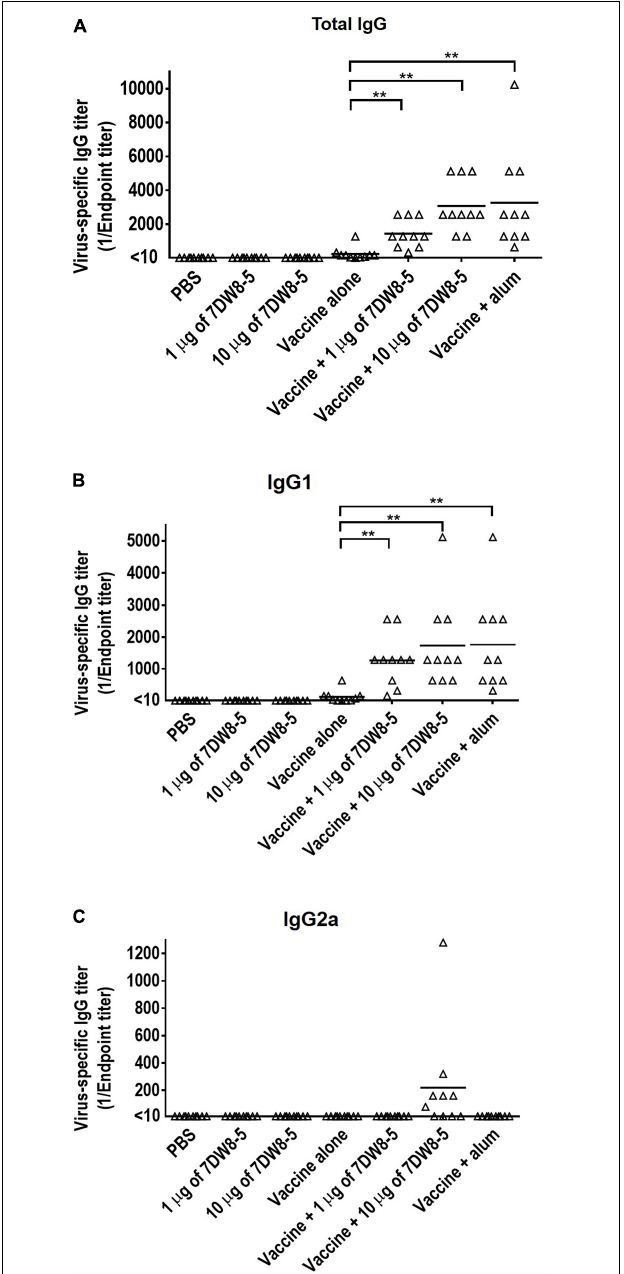
FIGURE 1 | Virus-specific antibody titers induced by 7DW8-5 in combination with HA vaccine in mice. Six-week-old BALB/c mice ( n = 10) were immunized with a commercial influenza HA vaccine with or without adjuvant twice with a 2-week interval between the vaccinations. Blood samples were collected 2 weeks after the second immunization. Virus-specific antibodies were measured by using an ELISA with inactivated and purified CA07 virus as the coating antigen. (A) Virus-specific total IgG antibody titers; (B) virus-specific IgG1 antibody titers; (C) virus-specific IgG2a antibody titers. The data were analyzed by using a one-way ANOVA followed by Tukey’s Post Hoc tests. The data were log2 transformed before the comparisons to stabilize the variance. The lines indicate the means of the antibody titers ( n = 10). Values < 10 were assigned the value 5 as described in the section “Materials and Methods.” ∗∗ P < 0.01.